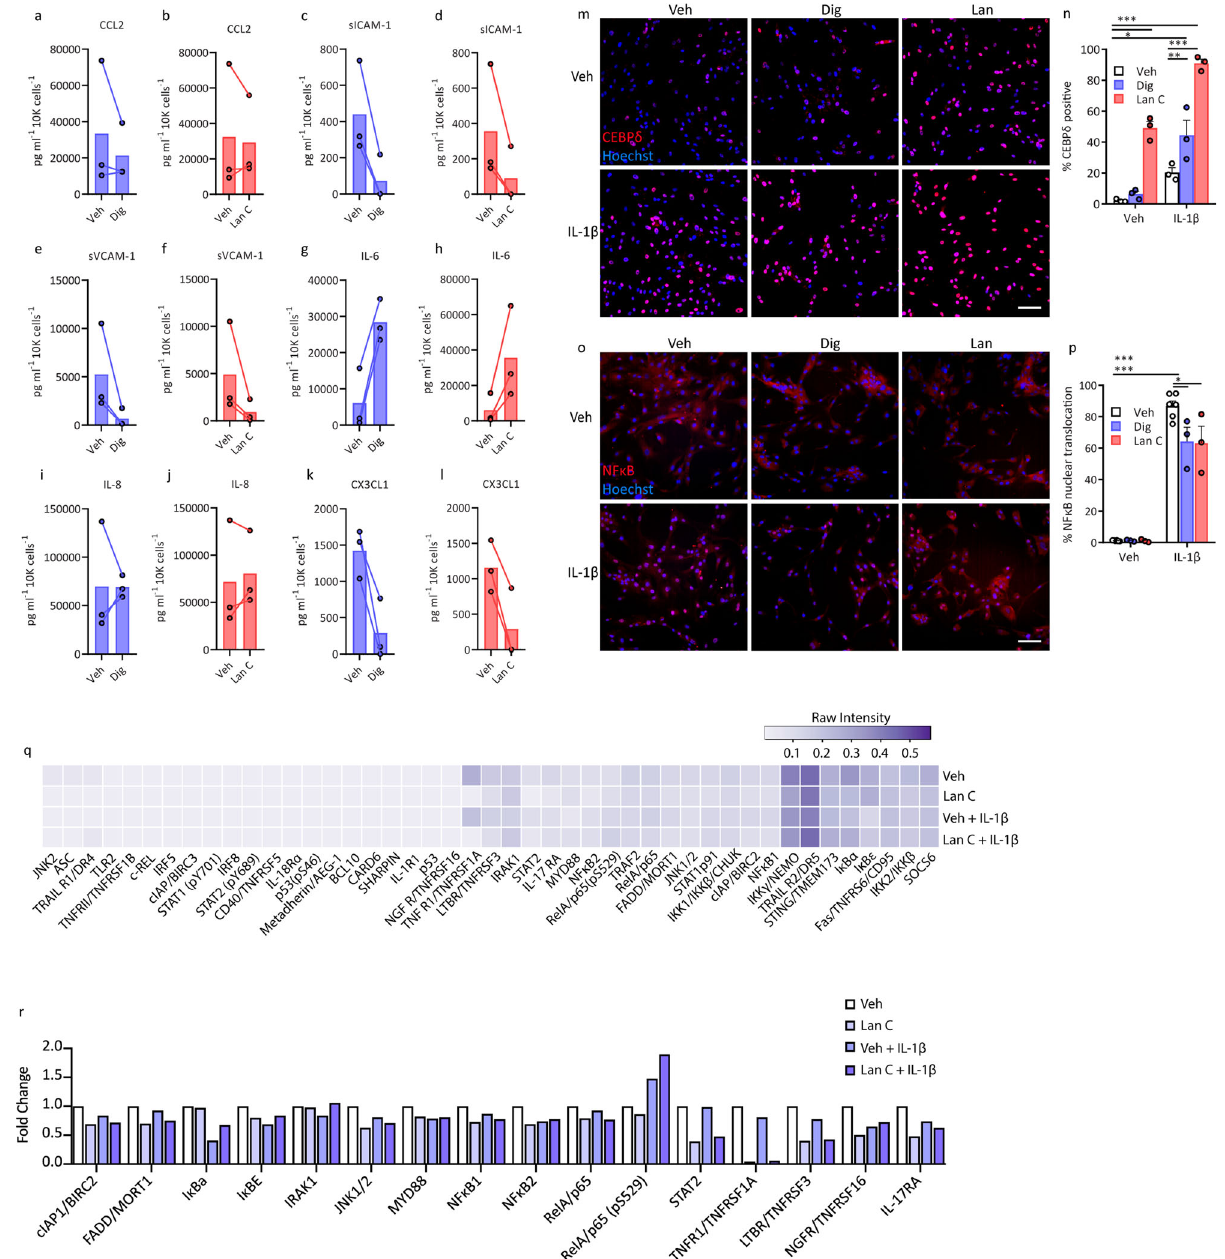
Fig. 2 Cardiac glycosides digoxin and lanatoside C modify in fl ammation-dependent transcriptional responses in pericytes. a – l Conditioned media from pericytes after 24 h of vehicle, digoxin (blue bars) or lanatoside C (red bars) (125 nM points selected from concentration curves in Fig. S2) pre-treatment prior to stimulation with IL1 β (0.05 ng mL − 1 ) for 24 h ( n = 3, cases used: E206, E213, E214). m – p Pericytes pre-treated with digoxin (100 nM) or